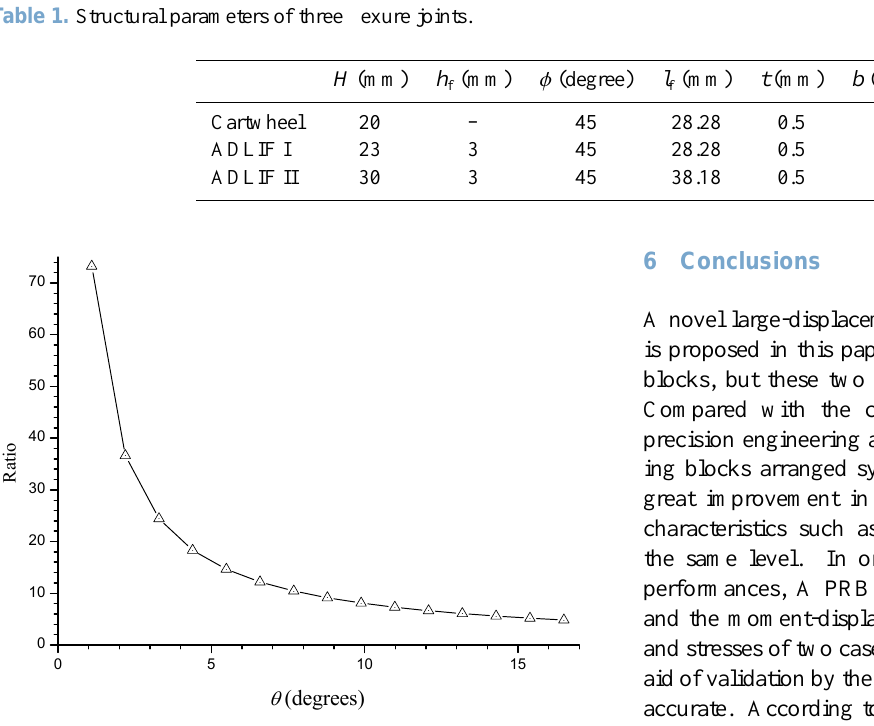
Fig. 5 Center-shifts ratio of the cartwheel hinge to the ADLIF II Figure 5. Center-shifts ratio of the cartwheel hinge to the ADLIF